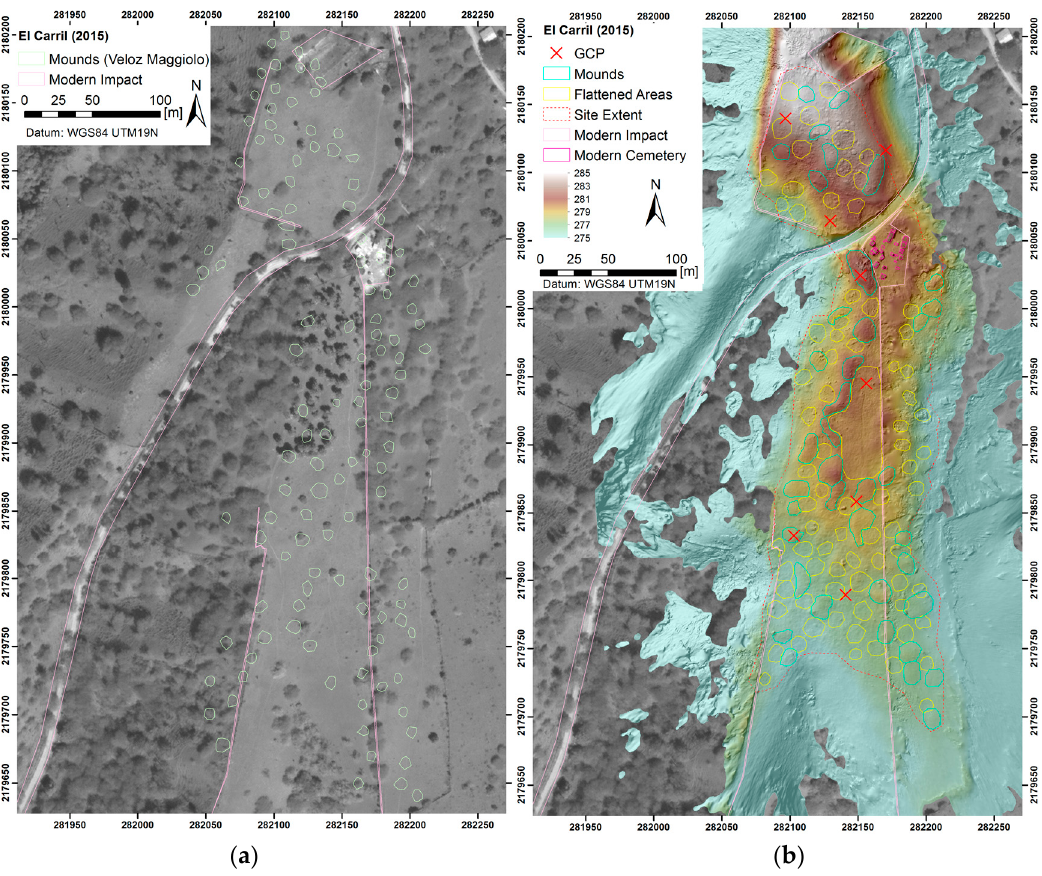
Figure 8. The mounds of El Carril ( a ) as envisioned by Veloz Magiollo [49]; ( b ) interpretation from the DEM of mounds and flattened areas. (Background: Worldview-2 Panchromatic_12MAR0215) Source: Digital Globe Foundation).